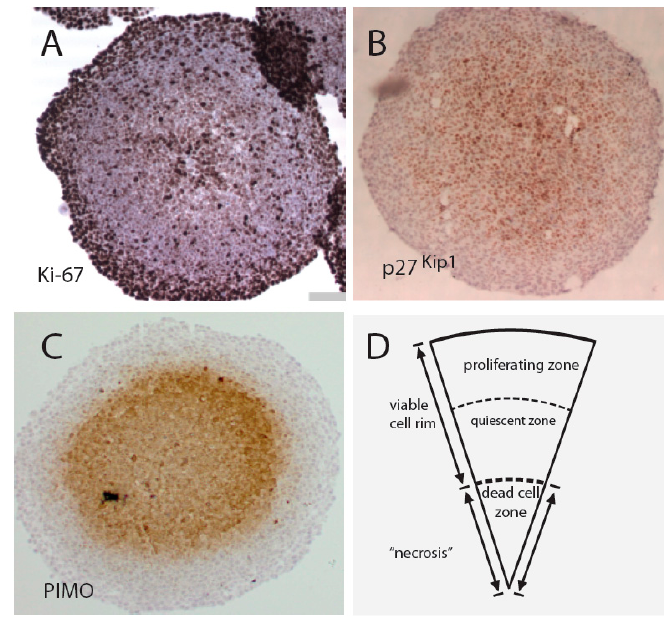
Figure 2. Properties of HCT116 colon cancer spheroids. HCT116 spheroids were grown in 96-well plates for five days, fixed, sectioned and stained with different antibodies. Proliferating cells (Ki-67 positive) are present in peripheral layers ( A ) and quiescent cells (p27 Kip1 positive) in the core ( B ); Core layers are also severely hypoxic and positive for pimonidazole (PIMO) adducts ( C ); Large spheroids also contain central areas of necrosis ( D